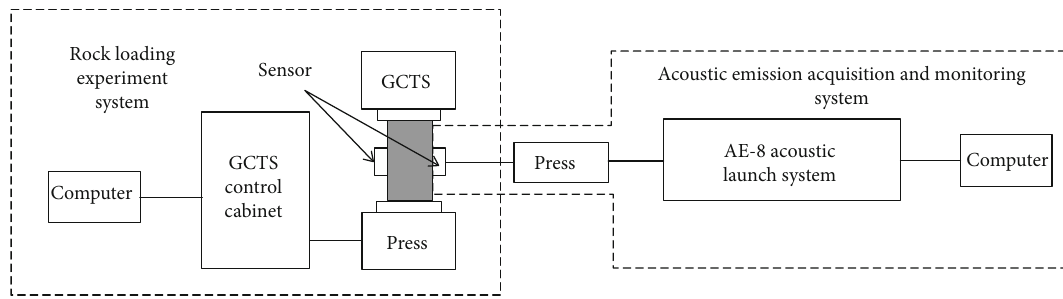
Figure 2: The uniaxial compression and acoustic emission testing systems.